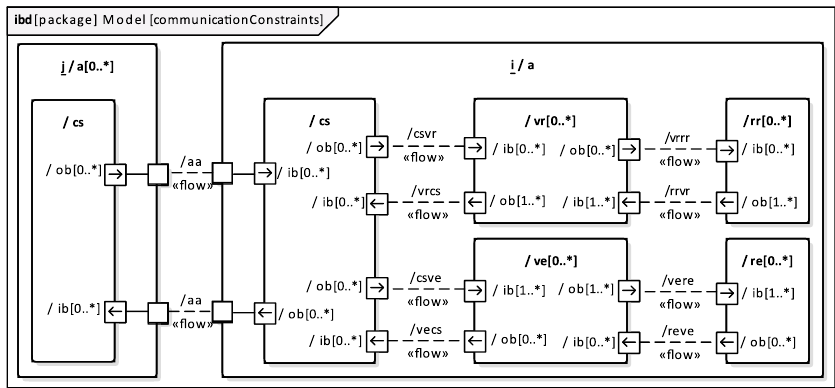
Figure 7. Communication constraints, where i (cid:54) = j